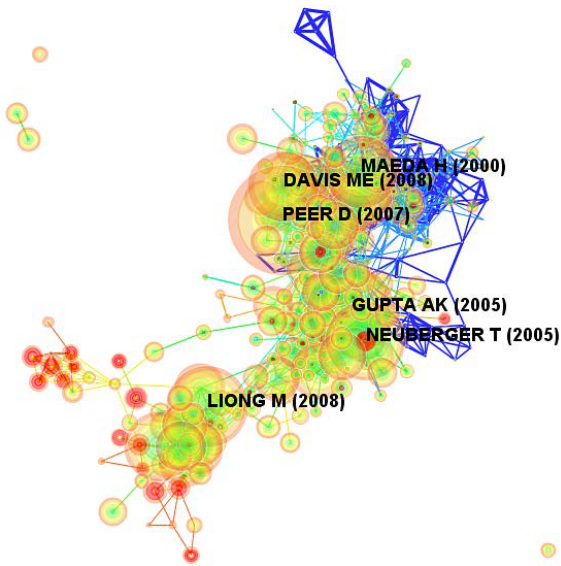
Figure 1. Key articles in nanoparticle drug delivery technologies.